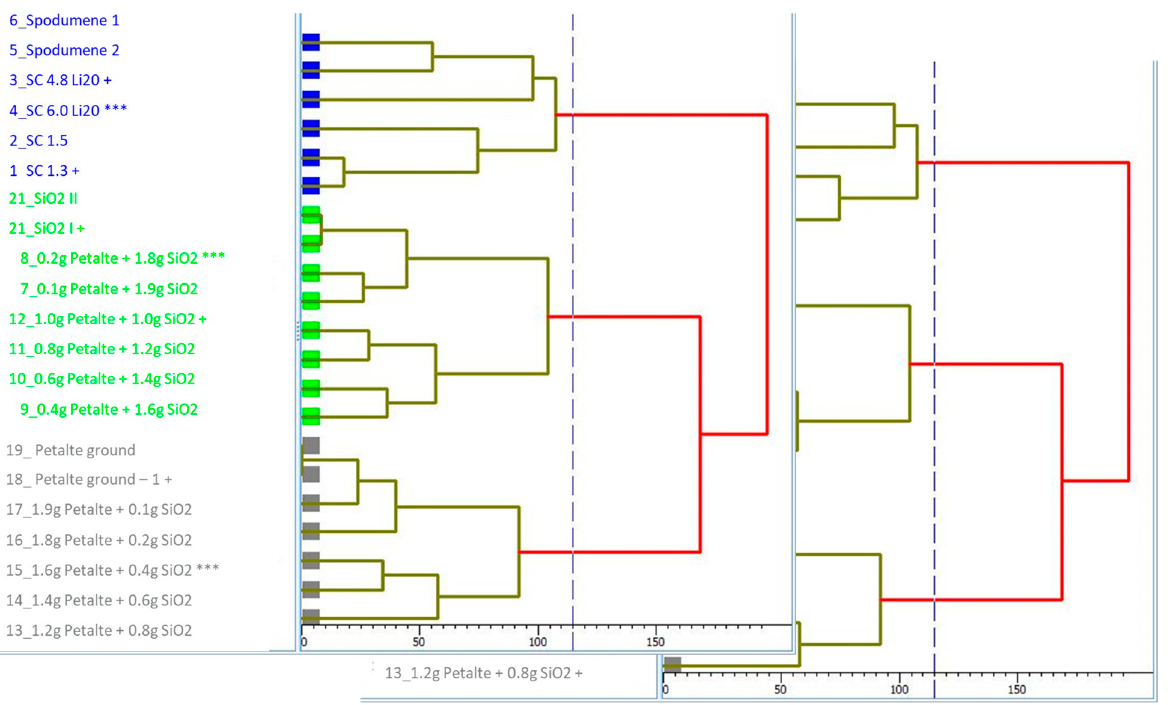
Figure 28. Dendrogram showing lithium ores from different parts of the world arranged in different clusters.